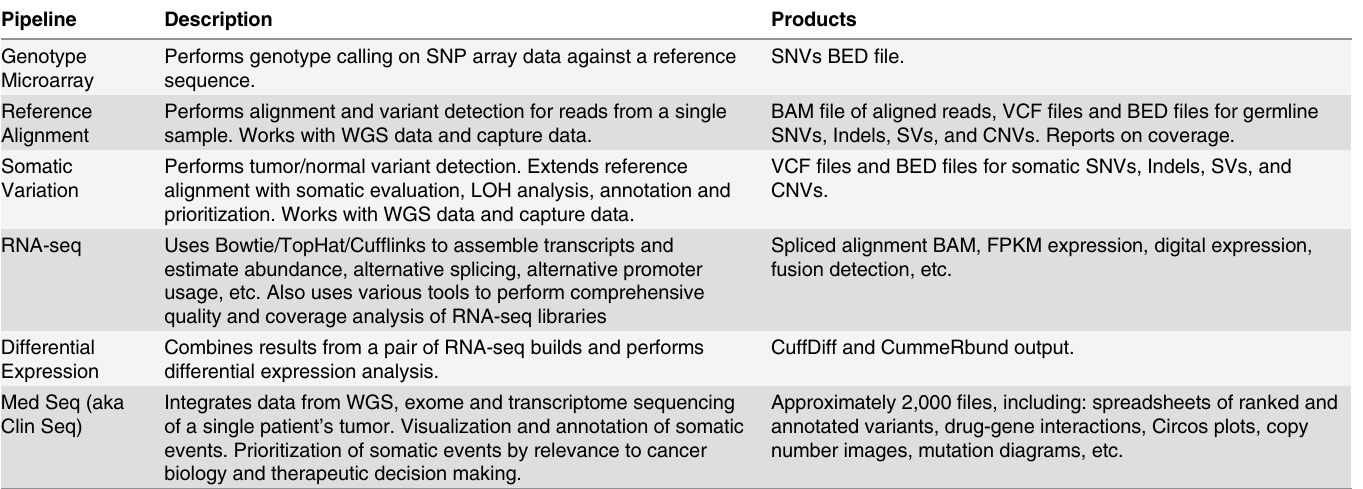
Table 1. Major GMS pipelines. A brief description of each analysis pipeline tested for initial release of the GMS.